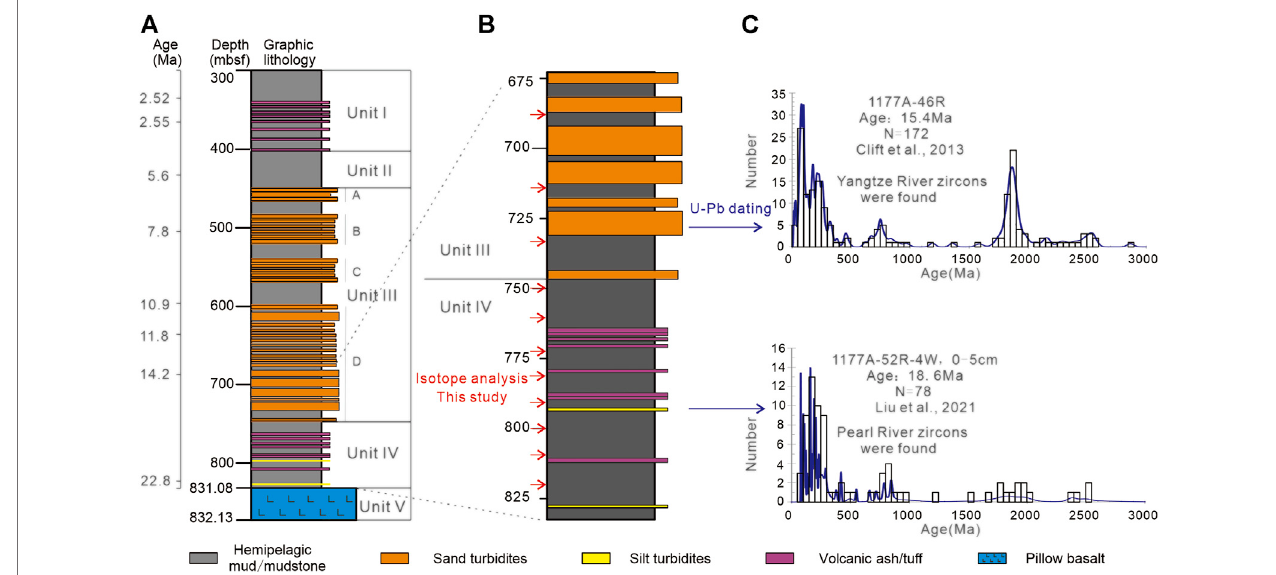
FIGURE 2 | (A) The stratigraphic column of ODP Site 1177. A, B, C, and D in Unit III represented four sand packets. mbsf = meters below sea fl oor. (B) A larger version of Panel 2A between 675 and 831 m. The red arrows indicate locations of 11 mudstone samples that Sr-Nd isotope experiments were conducted in this study. (C) The zircon age spectrum of turbidites from Site 1177. The blue arrows indicate locations of turbidites that zircon U-Pb dating experiments were performed in the previousstudy.ThesiltturbiditesweresourcedfromthePearlRiverat~18.6 Ma(Liuetal.,2021),andtheYangtzeRiverzirconswerefoundinthesandturbiditesat ~15.4 Ma (Clift et al.,